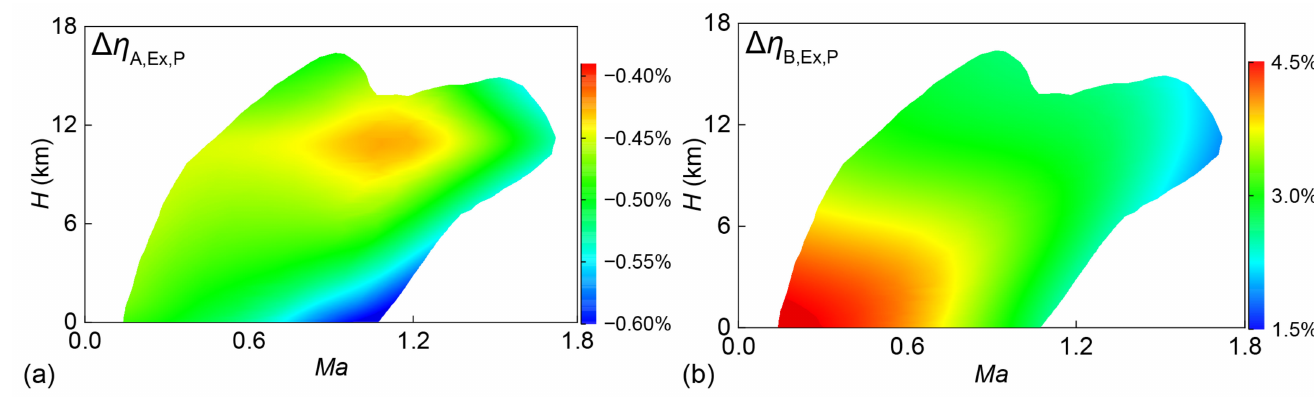
Figure 16. Variations of exergy loss rate in the full flight envelope. ( a ) The ratio of η A,Ex,Loss in schemes A and F-119; ( b ) The ratio of η B,Ex,Loss in schemes B and F-119.